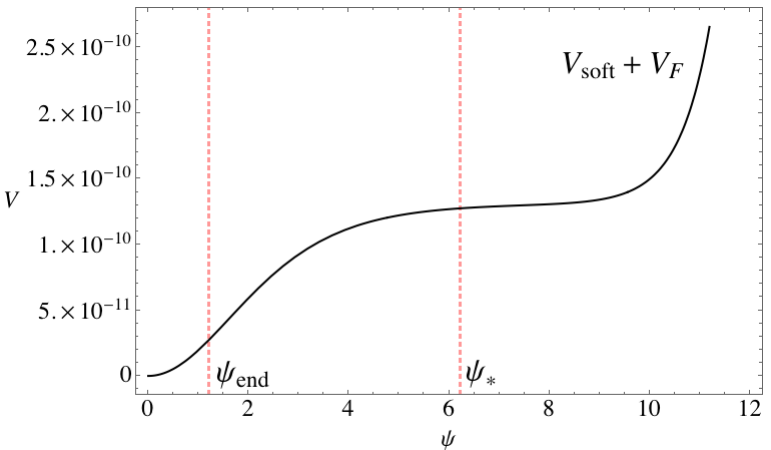
Figure 1. The black line is a graph of the potential V soft + V F for the parameters m = 6 : 49 (cid:2) 10 (cid:0) 6 , Y (cid:23) 3 (cid:24) 10 (cid:0) 12 and (cid:22) = 4 : 93 (cid:2) 10 (cid:0) 4 . For these values of the parameters, the vertical red dashed lines mark end ’ 1 : 21 and (cid:3) ’ 6 : 25 respectively. We have set M P =